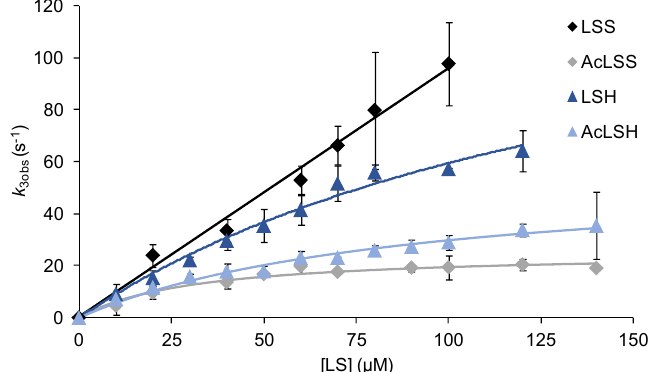
Figure 6. Kinetics of ApeLiP CII reduction to RS by native (black and dark blue) and acetylated (gray and light blue) softwood (LSS) and hardwood (LSH) lignosulfonates. Stopped-flow reactions were carried out in 100 mM sodium tartrate, pH 3, at 25 °C. Lignosulfonate concentrations refer to the basic phenylpropanoid unit. Means and 95% confidence limits are shown.